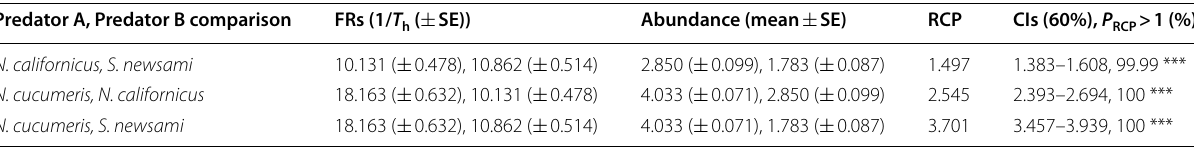
RCP score is > 1 (* > 95%, ** > 99%, *** > 99.9%) Table 5 Mean relative control potential (RCP) using fecundity (%) (Additional file 1: Table S1–3) across three life stages of P. citri for N. californicus , S. newsami, and N. cucumeris , that the RCP output exceeds 1 using bootstrapped maximum feeding and attack rates Predator A, Predator B comparison Prey stage FRs (1/ T h ( ±